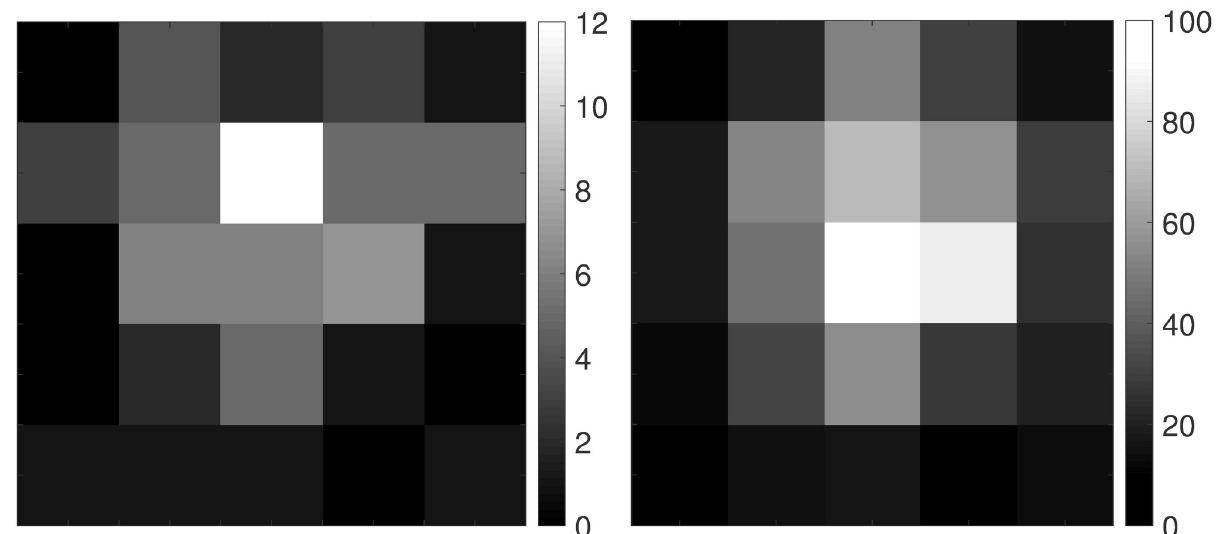
Fig 3. Typical images at low and high signal levels. (left) N = 1 and G = 10, (right) N = 10 and G = 100. Notice the different scaling in the two bgd bgd images. https://doi.org/10.1371/journal.pone.0243115.g003 position estimates produced by the U-EM algorithm as a typical estimation result, is shown in Fig 4. As described in the methods section, the EM algorithm at the heart of the simultaneous approach is an iterative scheme, improving the estimate at each iteration as it moves towards a local optimal of the log likelihood function. The resulting evolution of the diffusion coefficient parameter estimates over the 100 different trajectories for the three versions of SMC-EM and for U-EM are shown in the box plots in Fig 5. These plots show that the EM algorithm gener- ally converges in a small number of steps and that, as expected, the performance of SMC-EM improves as the number of Monte Carlo samples used in the PF and the PS increases. The comparison between the final results across the 100 trajectories for all the algorithms are shown in the box plots in Fig 6 and recapitulated in Table 2. Results in y are similar and are omitted for space reasons. Note that there is a clear bias in the diffusion coefficient estimation in the GF-MLE and in our EM based methods. This is likely driven by a variety of factors, including the length of the data set (since MLE methods are only guaranteed to be consistent, meaning that they converge to the true value as the amount of data becomes large) and nonlin- earities in the models. A close examination of the SMC-EM results shows that bias reduces as we go from SMC-EM 100 to SMC-EM 500 and then to SMC-EM 1000 . The SMC techniques more faithfully represent the nonlinear nature of the system as the number of MC samples. By con- trast, the UKF at the heart of U-EM is accurate only to second-order. This supports the Table 1. Fixed parameters used in the simulations. Symbol Parameter Value Symbol Parameter Value NA Numerical aperture 1.2 λ Emission wavelength Δ t Imaging period Number of